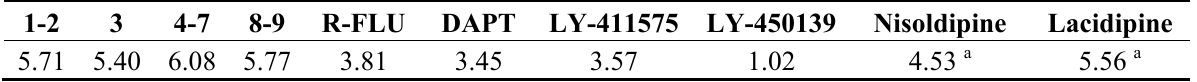
Table 1. c log P of compounds 1 – 9